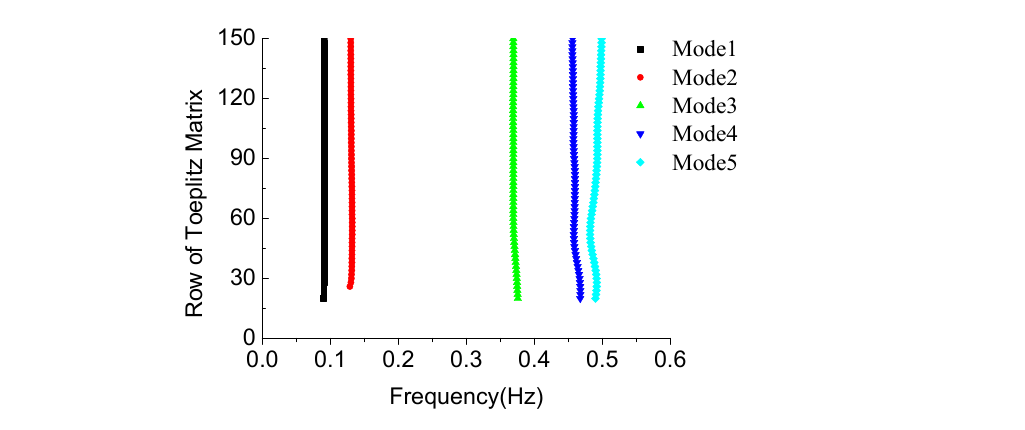
Figure 16. The identified frequency with the varying row of Toeplitz matrix by SSI method.